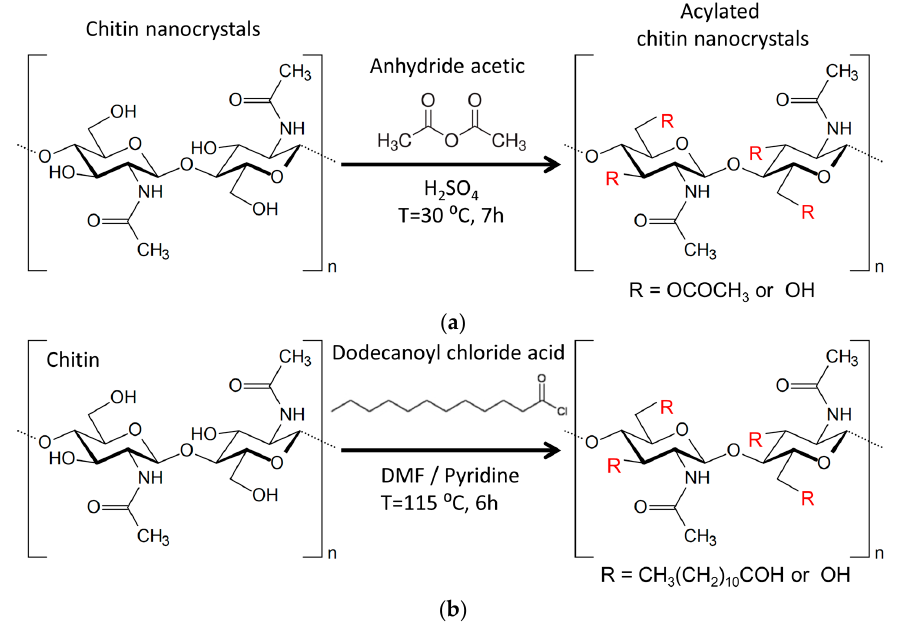
Figure 1. Scheme representing the heterogeneous chemical functionalization of chitin nanocrystals using: anhydride acetic ( a ); and dodecanoyl chloride acid ( b ).